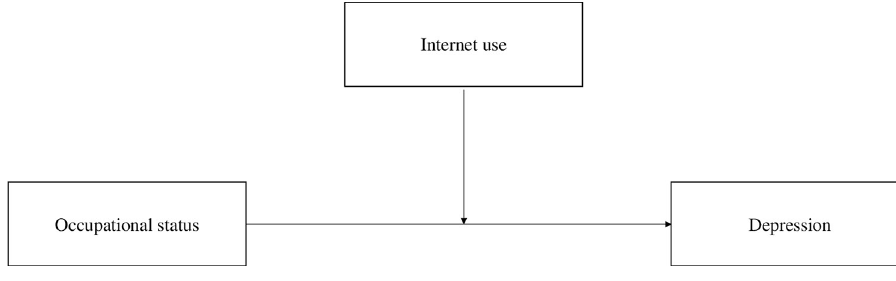
Fig 1. Research framework.